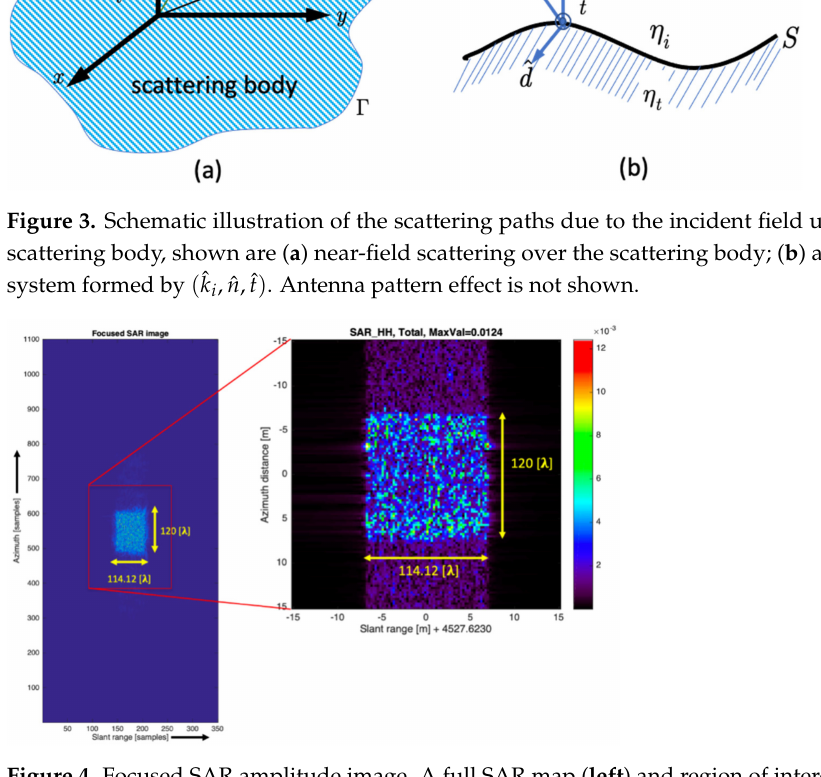
Figure 4. Focused SAR amplitude image. A full SAR map ( left ) and region of interest image ( right